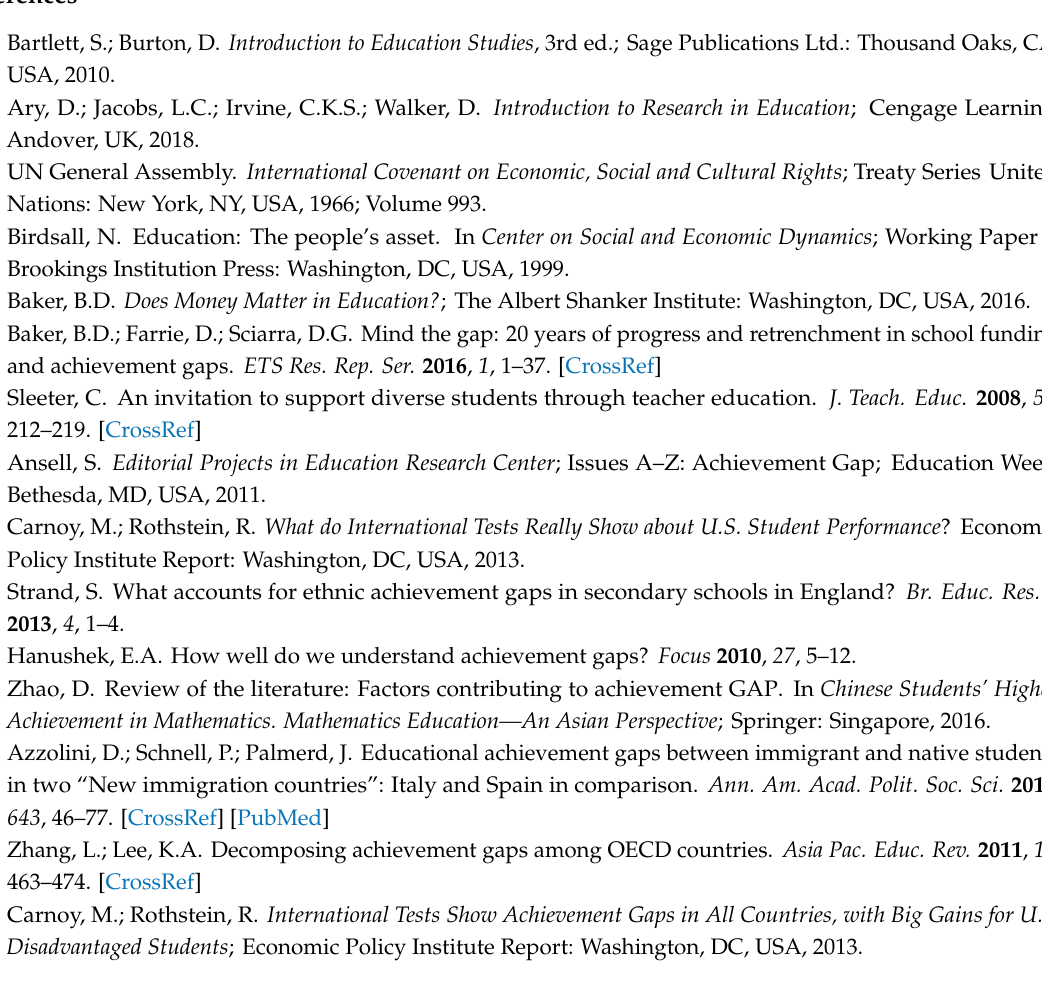
Table S1: Keywords for the inclusion criteria, values and brief description, Table S2: The mean performance scores and p -values for household income levels in mathematics, Table S3: The mean performance scores and p -values for household income levels in writing, Table S4: The mean performance scores and p -values for parental education levels in mathematics, Table S5: The mean performance scores and p -values for parental education levels in